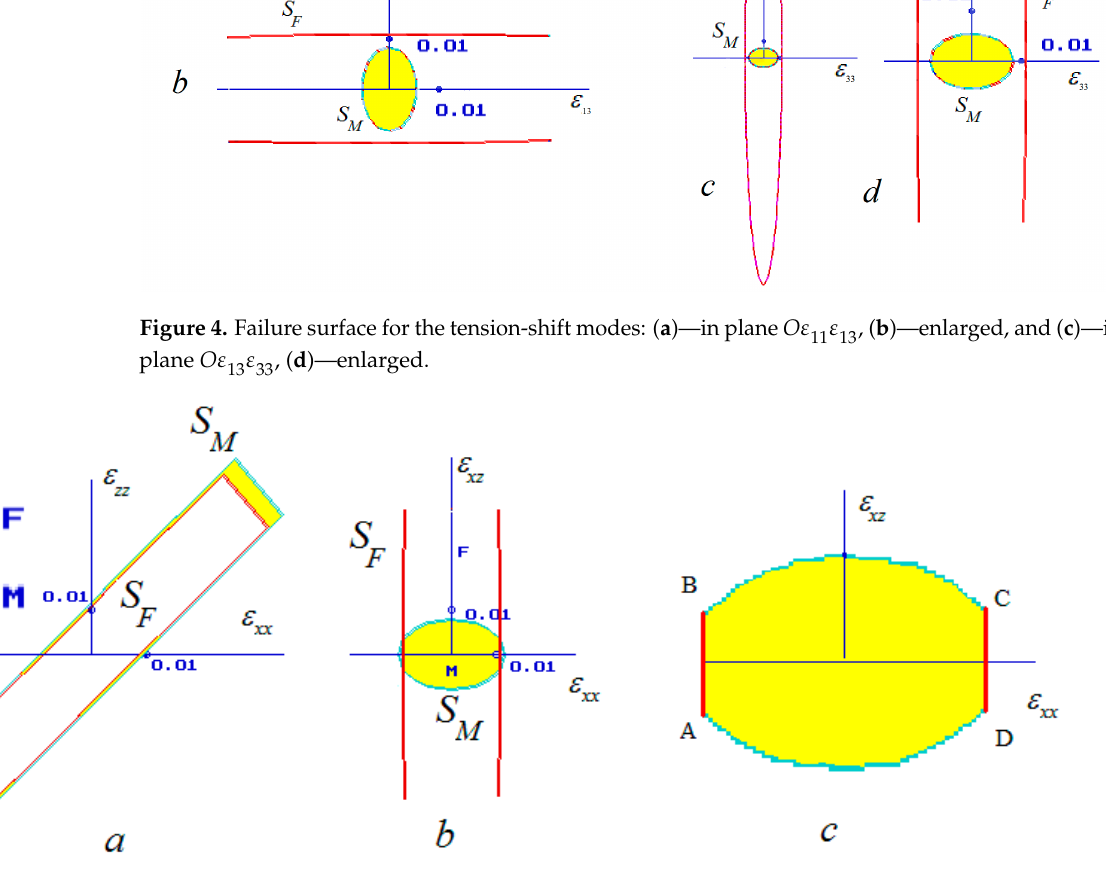
Figure 5. Failure surface: ( a )—for the tension modes; ( b )—for tension-shift mode; ( c )—for composite as a whole (the central part of Figure ( b ), enlarged).